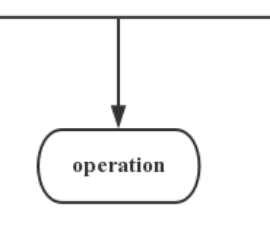
Fig. 2 Structure of Marine Industrial Robot Assembly Visual Positioning